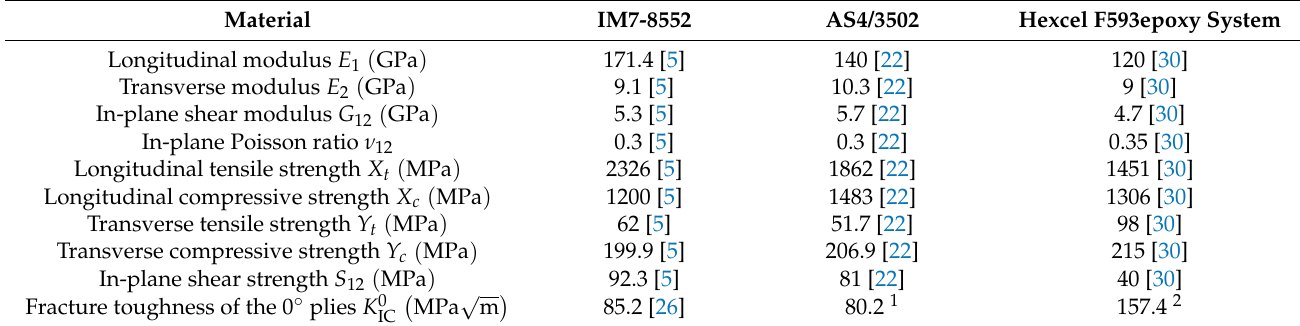
Table 1. Material properties.